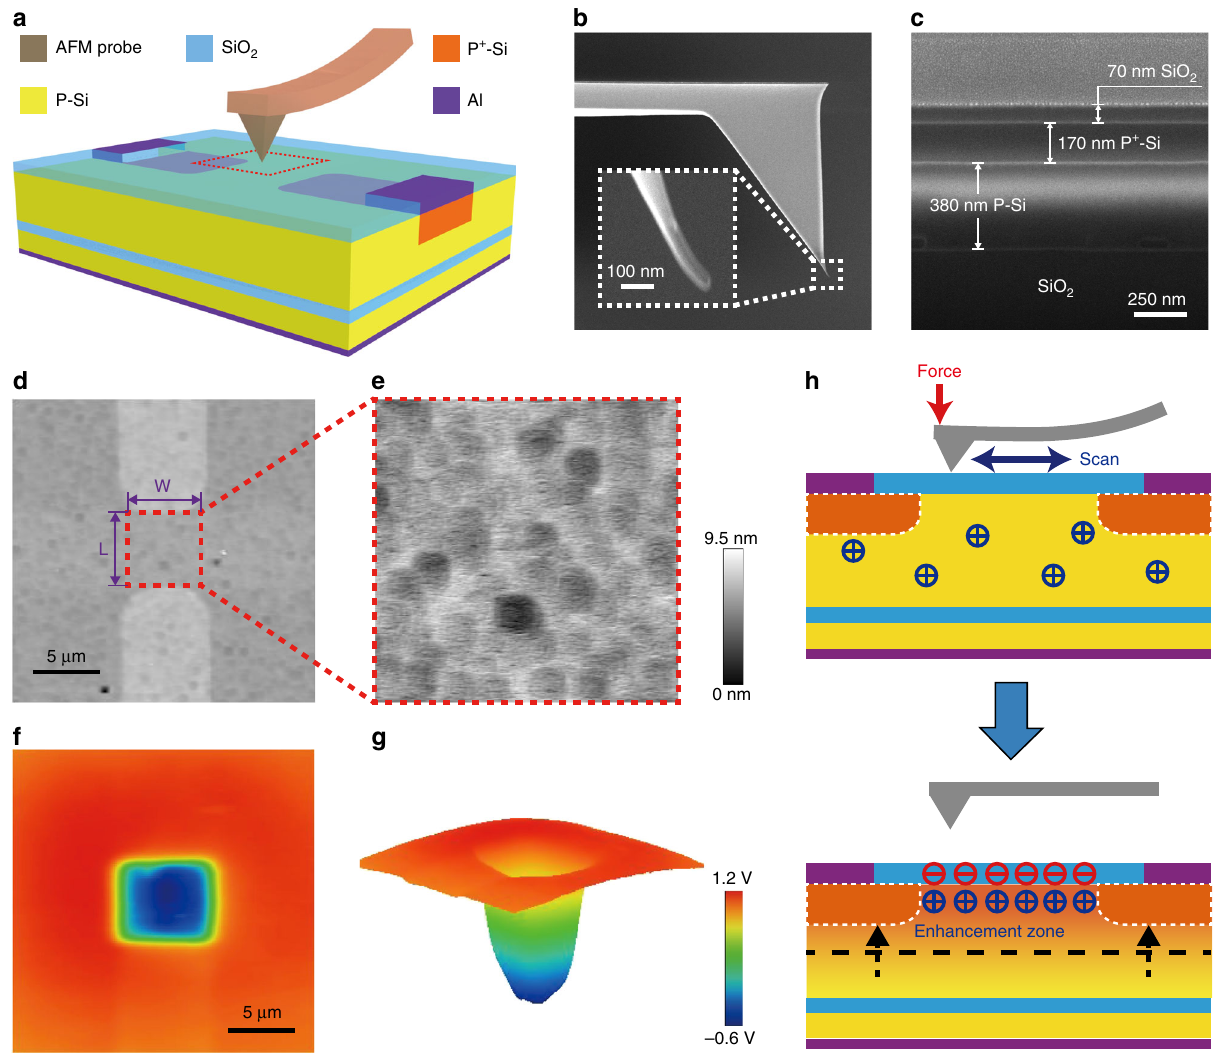
Fig. 1 Overview of the nanoscale triboelectri fi cation-gated transistor (NTT). a Schematic illustration of the NTT gated by nanoscale triboelectri fi cation. Scanning electron microscope (SEM) images of the ( b ) atomic force microscopy (AFM) tip and ( c ) NTT in cross-sectional view. AFM images of ( d ) the top SiO 2 surface in tapping mode and ( e ) the rubbed area above the channel region in contact mode. f Surface potential distribution of the top SiO 2 layer after regionally rubbed by the AFM tip measured in scanning Kevin probe microscopy (SKPM) mode. g 3D image of the measured surface potential distribution. h Schematic working principle of the NTT gated by nanoscale triboelectri fi